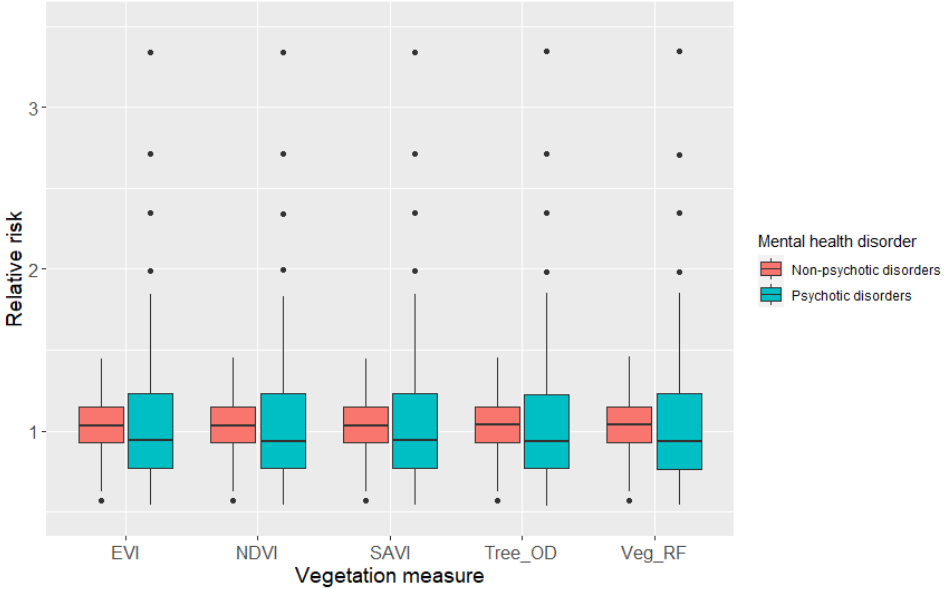
Figure 5. Box plot diagram showing the posterior mean of relative risks of psychotic and non- psychotic disorders. The relative risk values are shown for each of the five different vegetation measures in the 140 neighborhoods in Toronto.